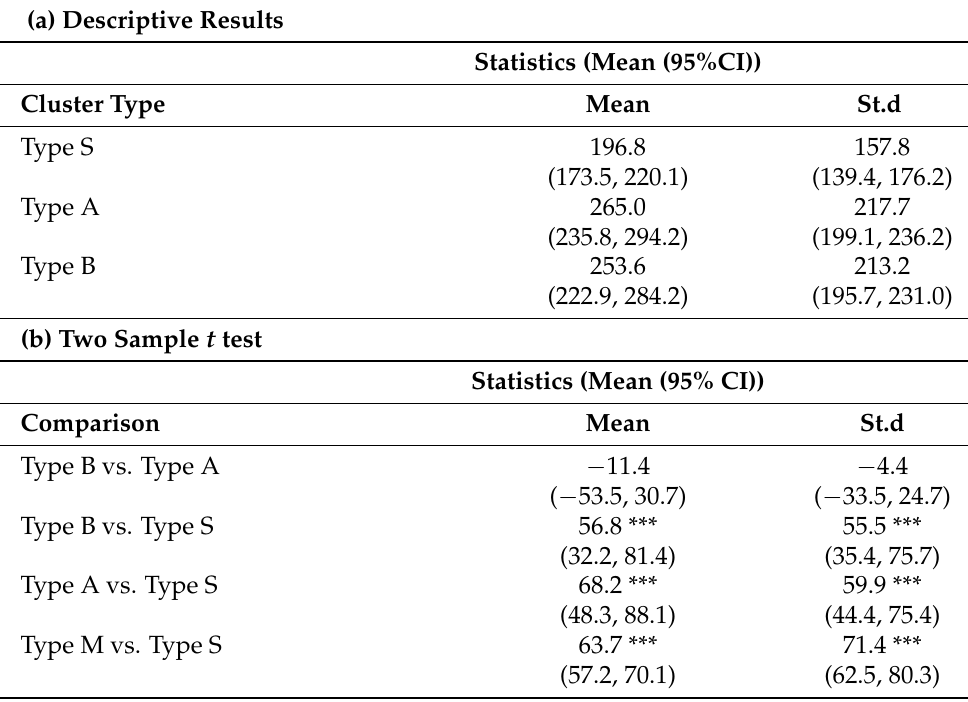
Table 2. Descriptive results for mean and standard deviation of fitted IBPA ex-Gaussian distribution to SSRT given cluster type ( n =